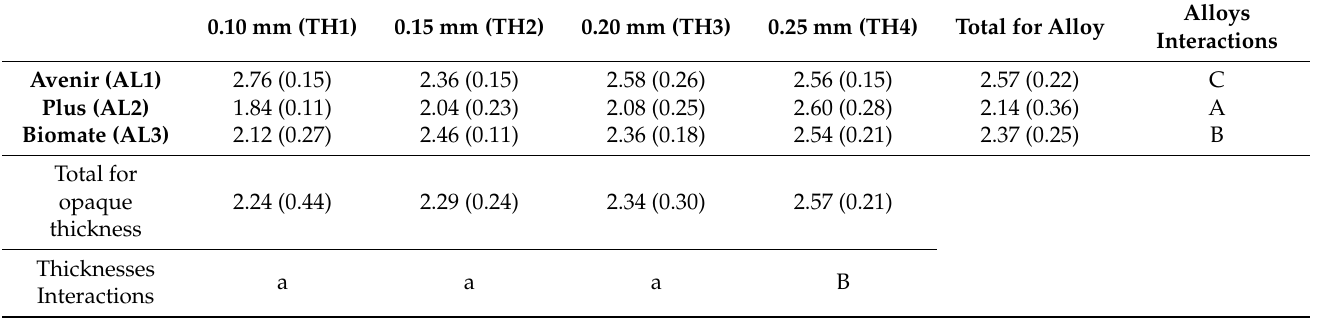
Table 4. Vita Easyshade color evaluation of the VM13 ceramic in 2M3 shade specimens. Measure- ments were performed in “restoration” mode. ∆ E values represent the differences with standard color parameters for the selected shade set in the instrument. In the interaction column and row, different letters significant differences when interactions were assessed at the univariate